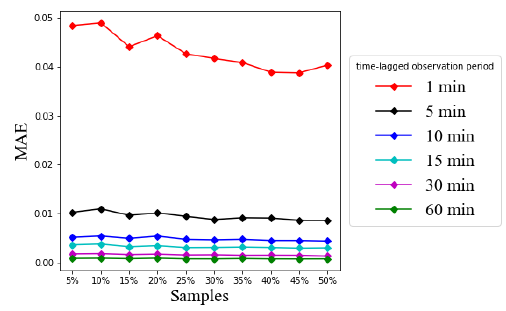
Figure 13. RMSE with varied time-lagged observation period.